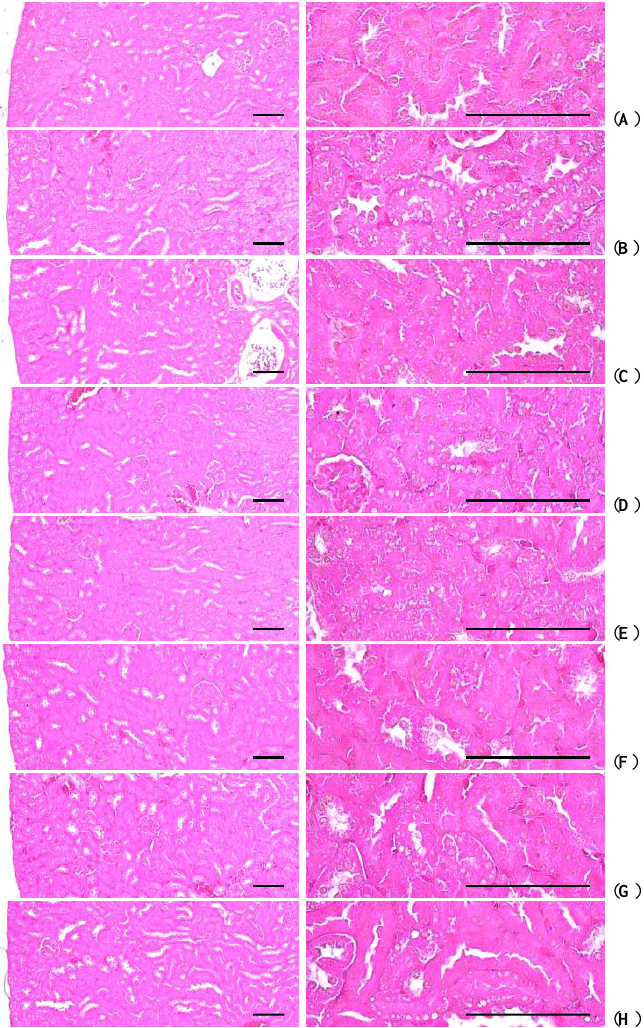
Figure 9. Representative histological images of the kidney, taken from NFD or HFD supplied mice. ( A ) Intact control: Normal pellet diet supplied vehicle control mice; 10 mL/kg of distilled water oral administered mice; ( B ) HFD (vehicle) control: 10 mL/kg of distilled water oral administered mice with HFD supply; ( C ) Simvastatin: 10 mg/kg of simvastatin oral administered mice with HFD supply; ( D ) Metformin: 250 mg/kg of metformin oral administered mice with HFD supply; ( E ) GT400: 400 mg/kg of GT oral administered mice with HFD supply; ( F ) fGT400: 400 mg/kg of fGT oral administered mice with HFD supply; ( G ) fGT200: 200 mg/kg of fGT oral administered mice with HFD supply; ( H ) fGT100: 100 mg/kg of fGT oral administered mice with HFD supply. NFD, normal fat pellet diet; HFD, high fat diet; GT, green tea extracts; fGT, Aquilariae lignum -fermented green tea extracts. All Hematoxylin & Eosin stain. Scale bars = 80 µm.